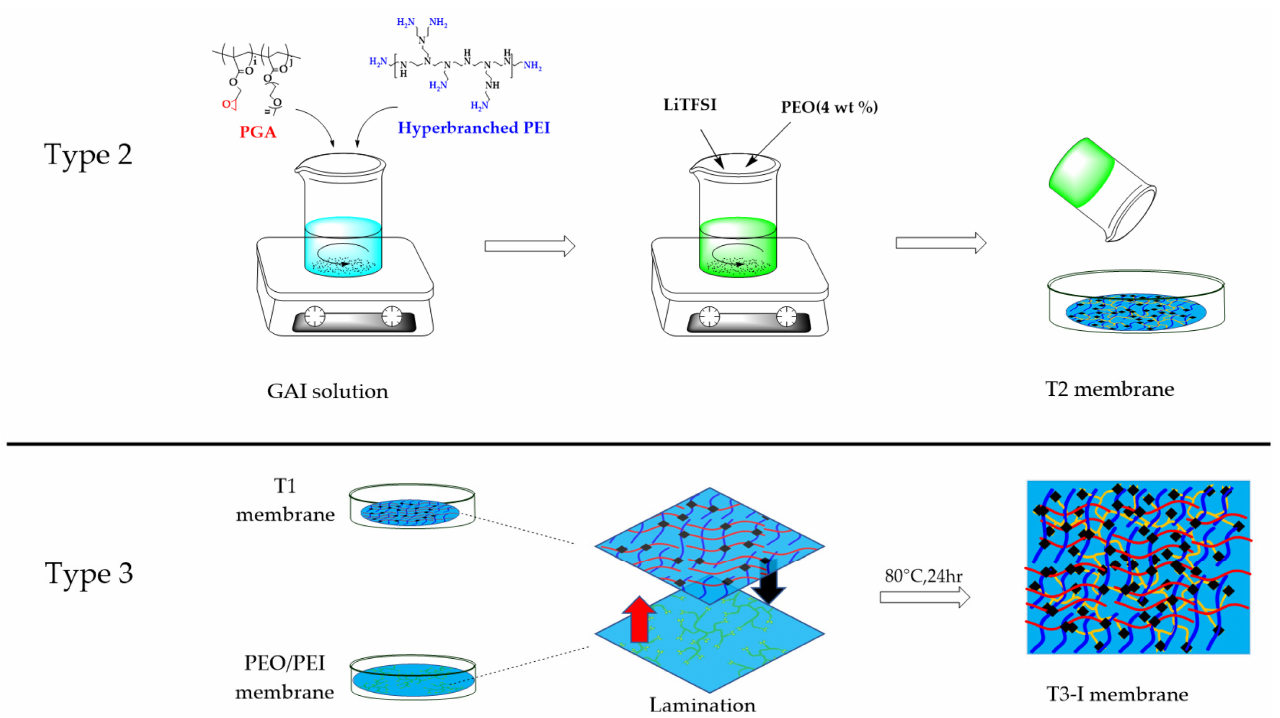
Scheme 2. Preparation processes of SPE